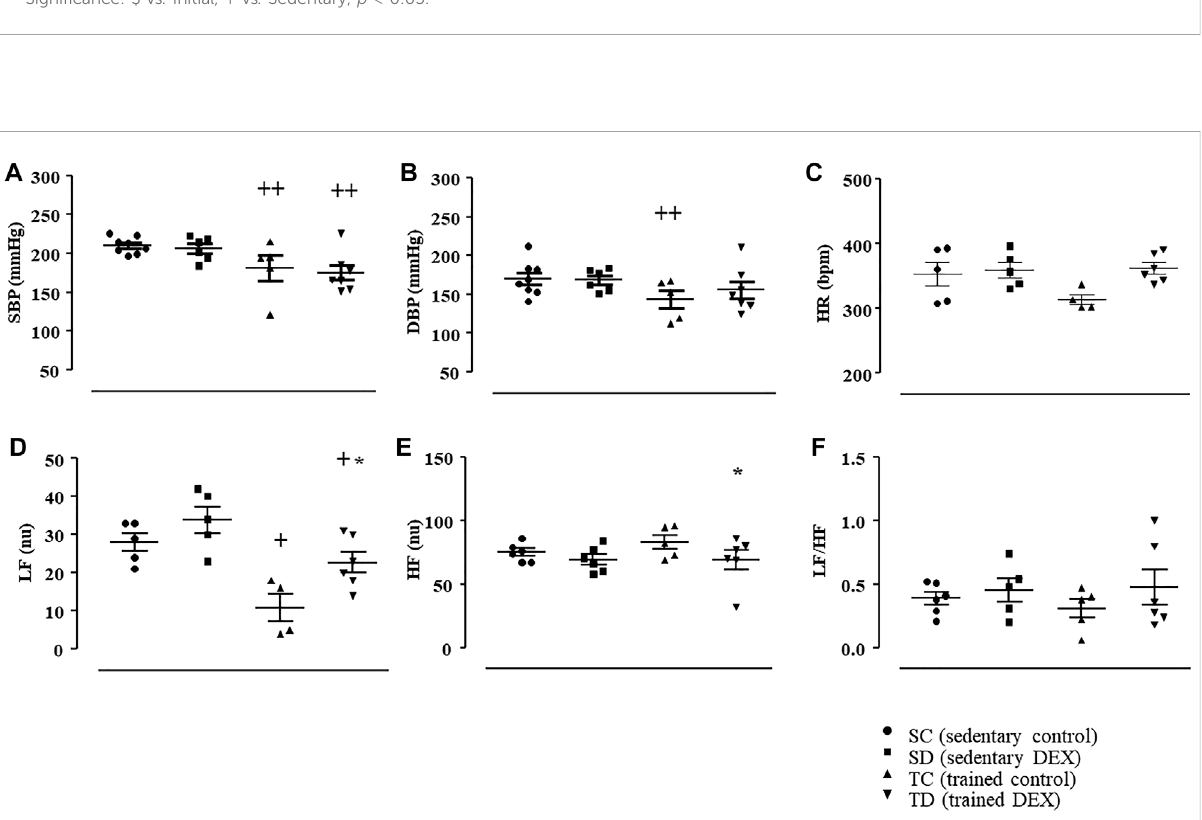
FIGURE 3 Values of systolic blood pressure (A ), SBP measured by plethysmography, mmHg) and estimated pulse wave velocity (B) , PWV, m/s) at theinitial and fi nal moments of the training protocol (8 weeks), before dexamethasone treatment in all SHR groups: Sedentary (n = 23) and Trained ( n = 28). Signi fi cance: $ vs . Initial, + vs . Sedentary; p < 0.05.